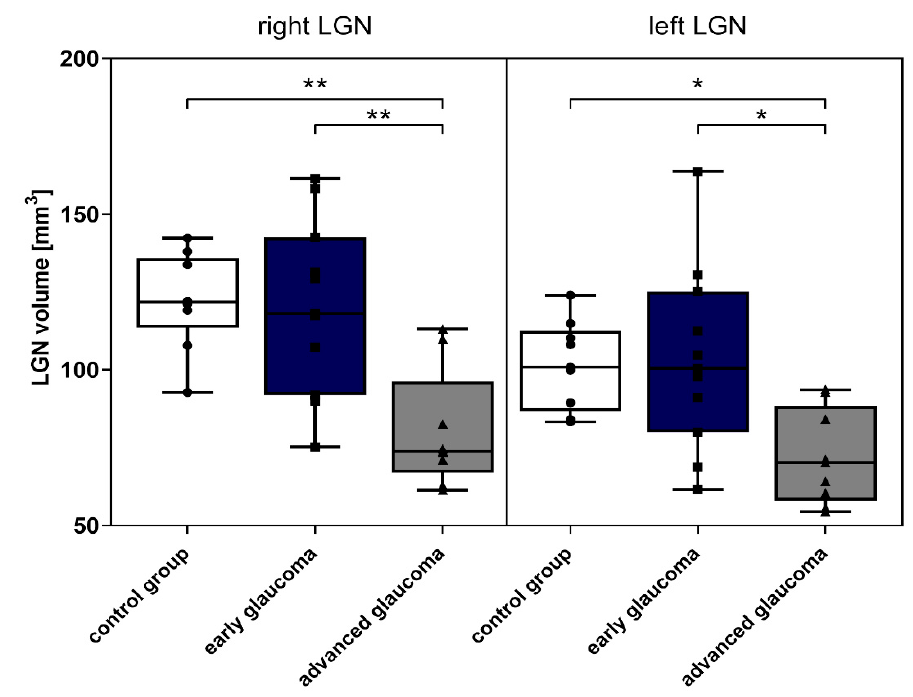
Figure 3. LGNs volume in examined groups—control, early and advanced glaucoma. Data represent Table 1. * p < 0.05, ** p < 0.01).